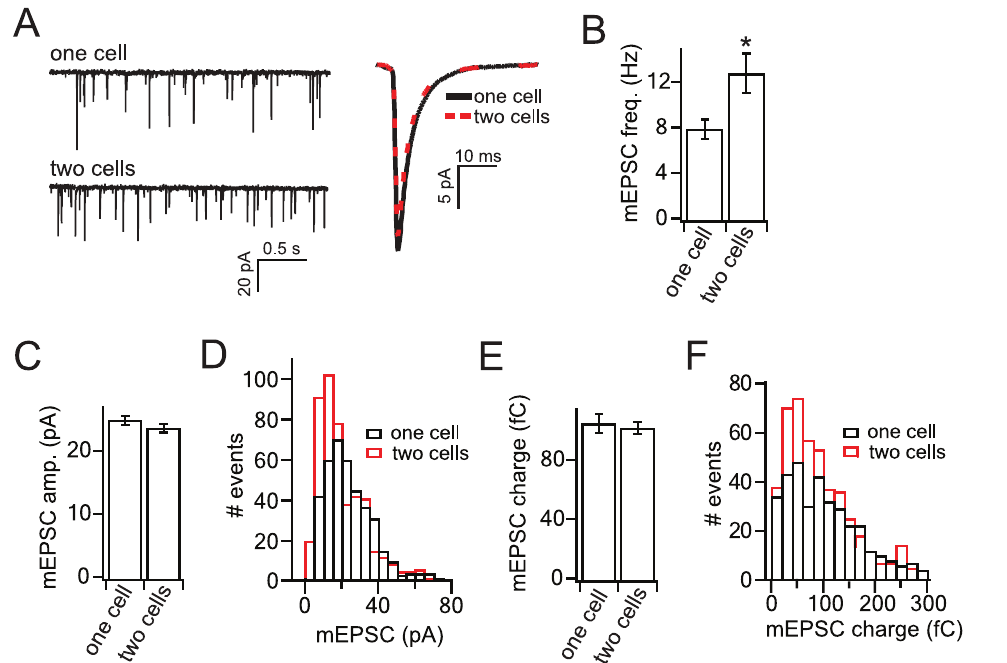
Figure 3. Autapses have reduced mEPSC frequency but no change in mEPSC amplitude, compared to neurons in two-cell micronetworks. (A) Representative mEPSC recordings from neurons in one-cell or two-cell micronetworks. (B) Average mEPSC frequency recorded from one-cell island autapses and from neurons in two-cell micronetworks. (C) Average mEPSC amplitude in one-cell autapses and from neurons in two-cell micronetworks. (D) Distribution of mEPSC amplitudes in one and two-cell networks (bin=5 pA). (E) Average mEPSC charge recorded from one-cell and two-cell micronetworks. (F) Distribution of mEPSC charge in one and two-cell networks (bin=20 fC). For B, C, and E, n=18 autapses and 20 neurons from two-neuron micronetworks. For distributions in D and F, n=400 mEPSCs from one-cell islands and 470 mEPSCs from two-cell islands. Statistical significance was determined by Student’s t-test (B, C, E) or Kolmogorov-Smirnov test (D, F). *=p , 0.05. All data shown represent mean 6 SEM. doi:10.1371/journal.pone.0062414.g003 frequency train stimulation (40 APs/2s), we compared RRP size, Autapses and autaptic synapses underwent significantly greater refilling rate and release probability in autapses, and autaptic and depression in response to the first few APs during stimulation at interneuronal synapses in two-neuron networks (Fig. 5A). 20 Hz, compared to interneuronal synapses (Fig. 5B). To de-